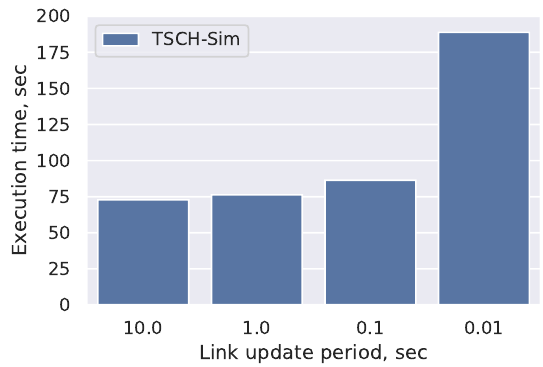
Figure 11. Impact of mobility on speed. 300 node mesh network; all nodes except the root are